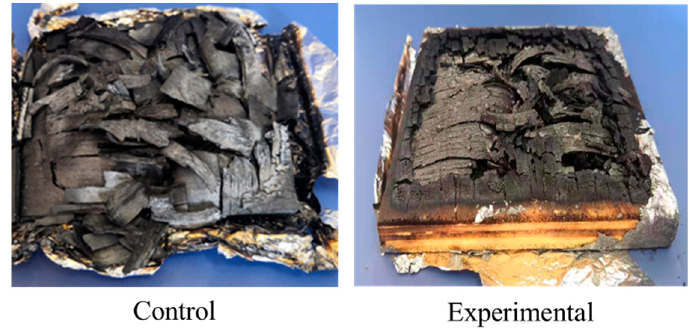
Figure 2. The state of plywood after